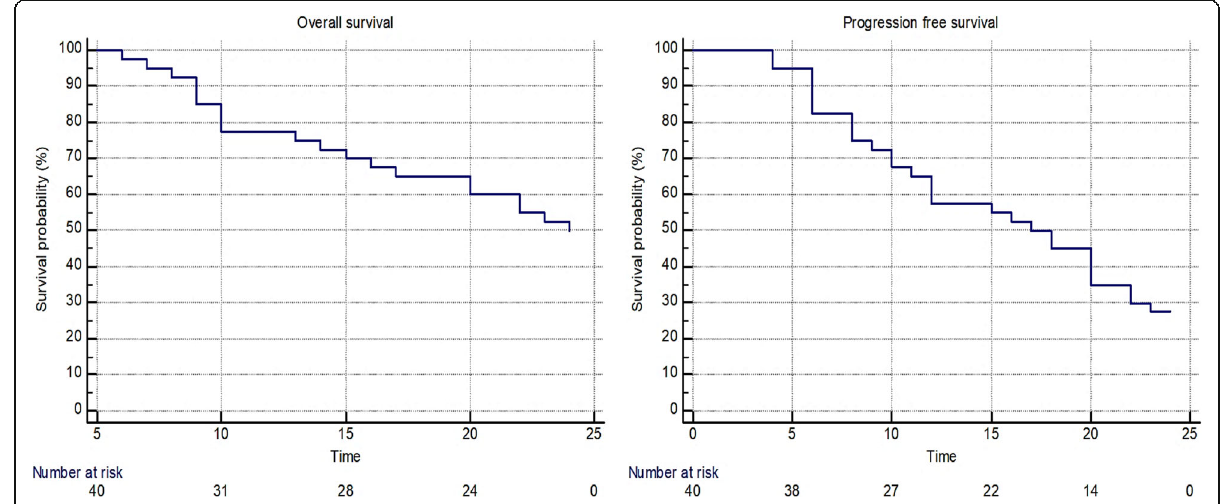
Fig. 2 Kaplan-Meier curves for overall survival (OS) and progression-free survival (PFS) in medulloblastoma patients